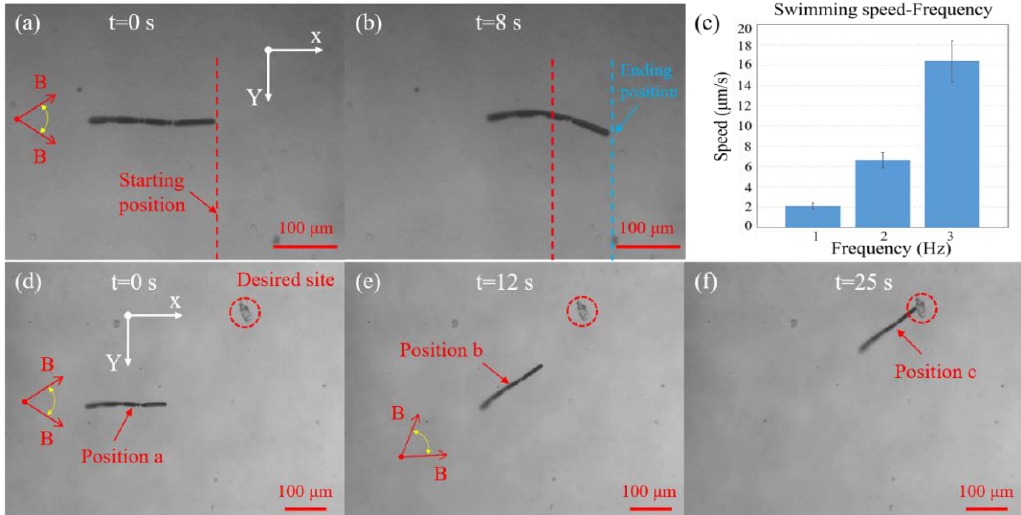
Figure 5. Free-swimming experiments of the microswimmer. ( a , b ) Net displacement of the microswimmer under an external oscillating magnetic field, where the oscillating frequency and amplitude of the magnetic field are 3 Hz and 45 degrees, respectively. The red dashed line indicates the starting position, and the blue dashed line indicates the ending position. Please refer to Video S2. ( c ) Microswimmer swimming speed against the frequency of the applied magnetic field. ( d – f ) Control the microswimmer to a desired site via external magnetic field. Please refer to Video S3.